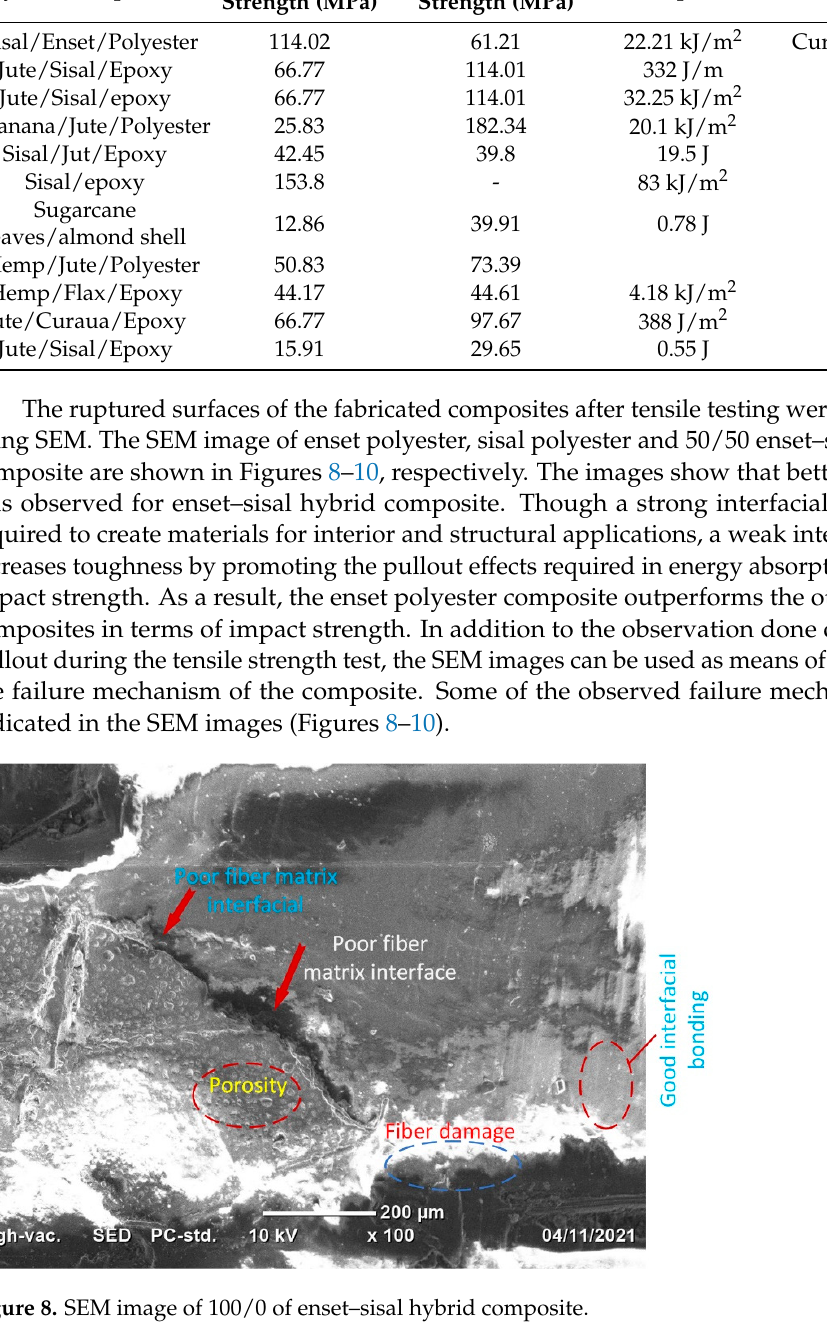
Figure 9. SEM image of 0/100 of enset–sisal hybrid composite.